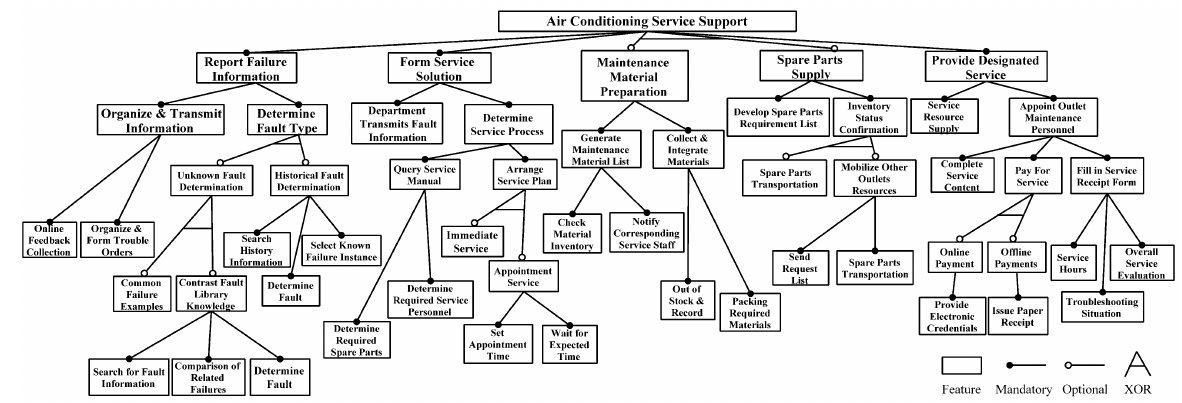
Figure 2. Air-conditioning service support feature